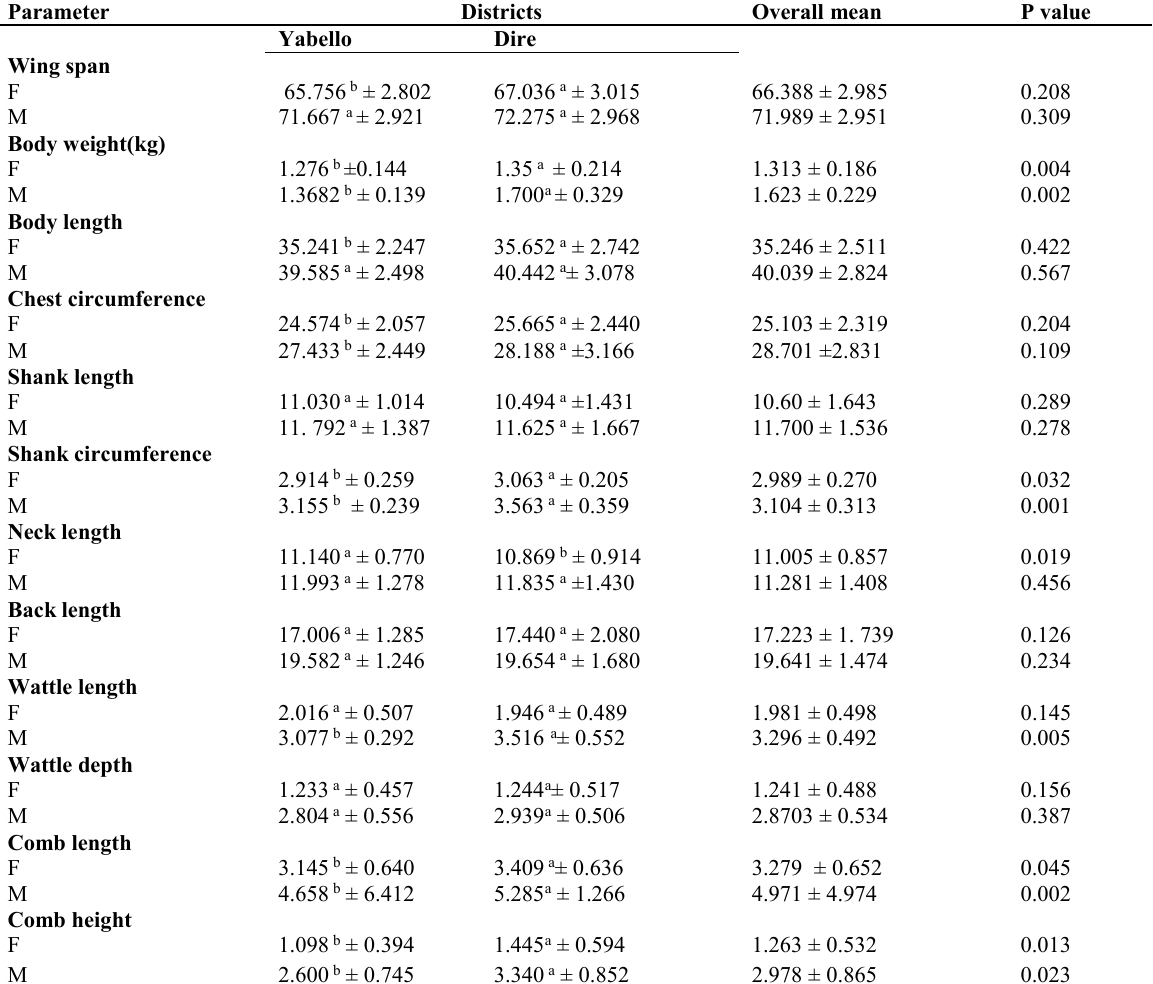
Table 3. Morphometric variation (LSM ± SD in kg for body weight and in cm for all other parameters) of local chickens in the study